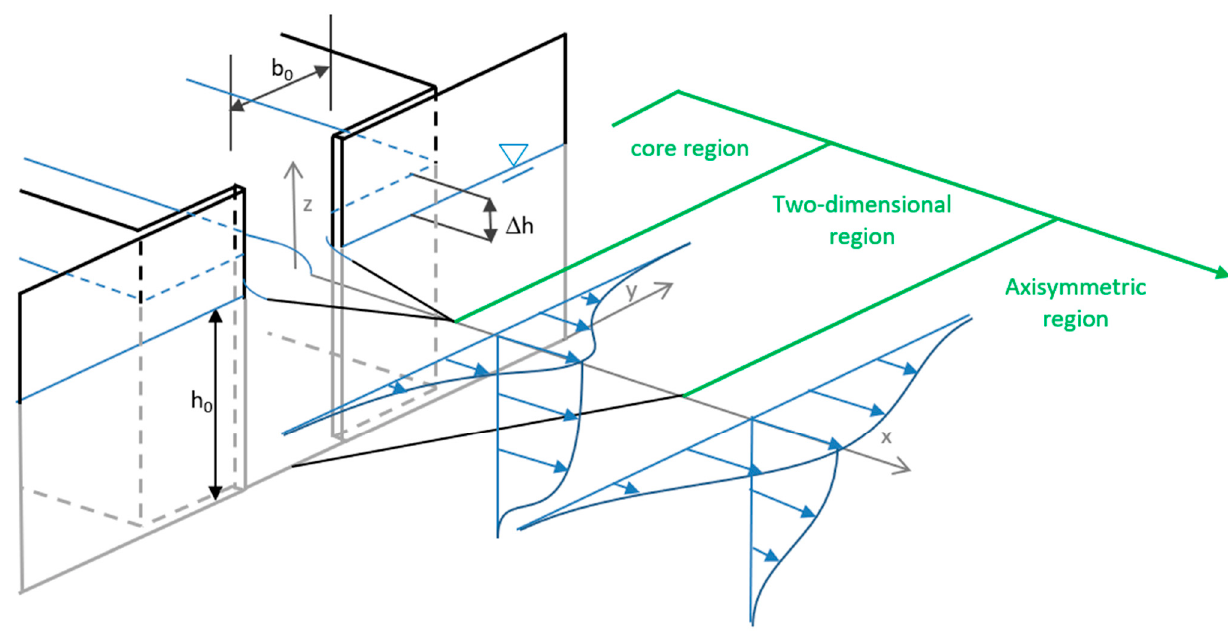
Figure 1. Schematic diagram of slot geometry typical for vertical slot fishways including the head drop and jet propagation from analytical models with flow for three-dimensional rectangular surface jets [6–9].